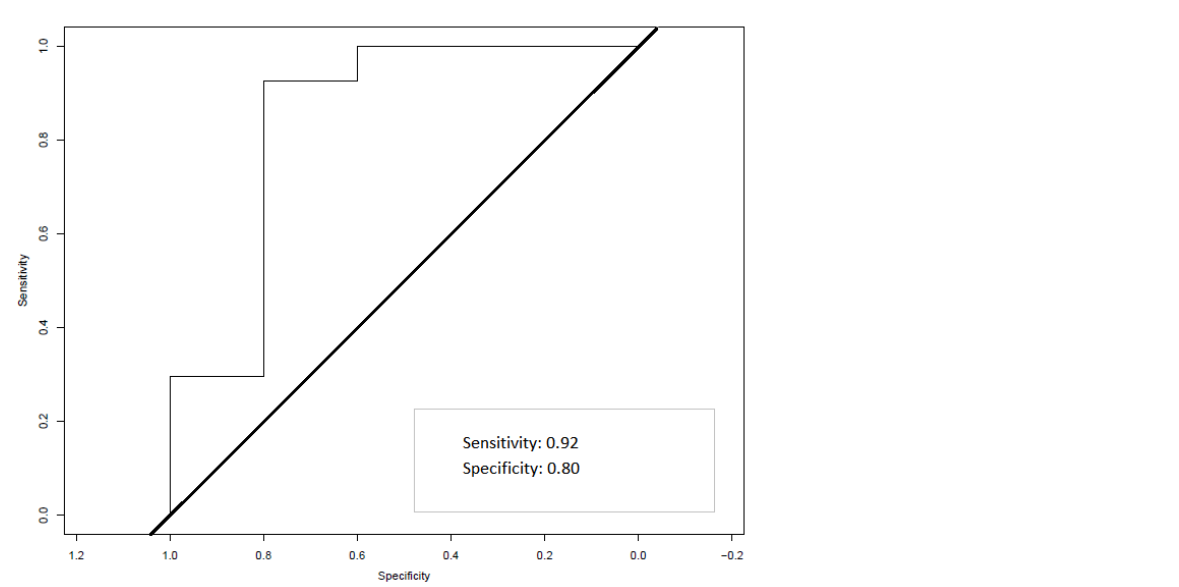
Figure 7 - ROC curve for the final model binary logistic regression